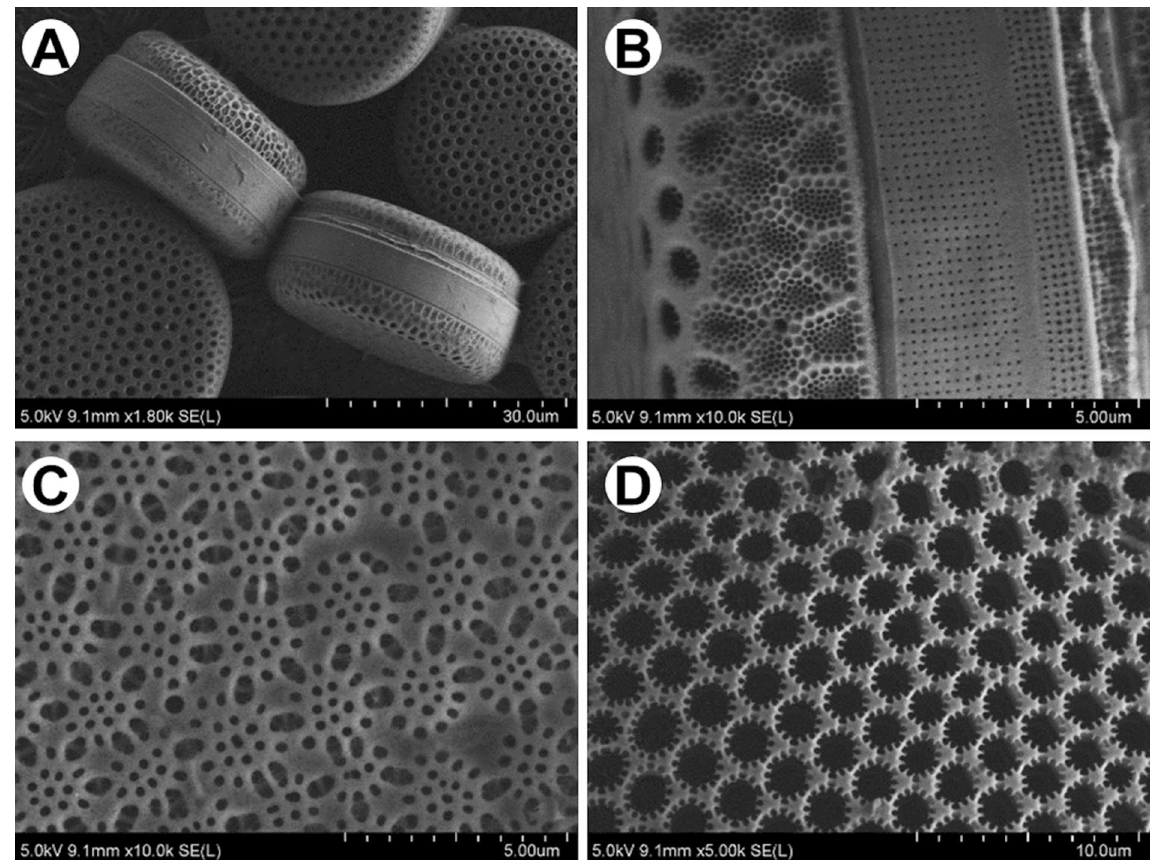
Figure 3. Scanning Electron Microscopy (SEM) images of ( A,B ) Endyctia sp. and ( C,D ) Coscinodiscus sp.: ( A ) valve and girdle view; ( B ) morphology from the girdle view; ( C ) outer side, ( D ) inner side of the